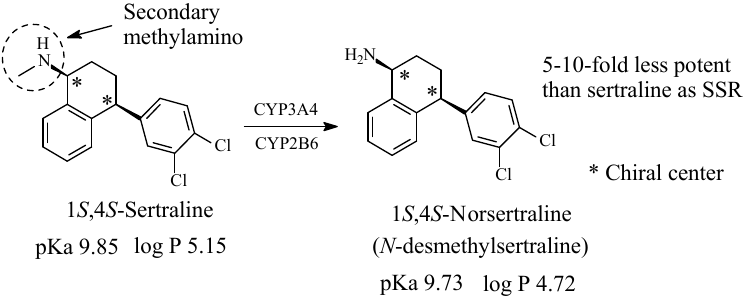
Figure 12. Metabolism of sertraline.